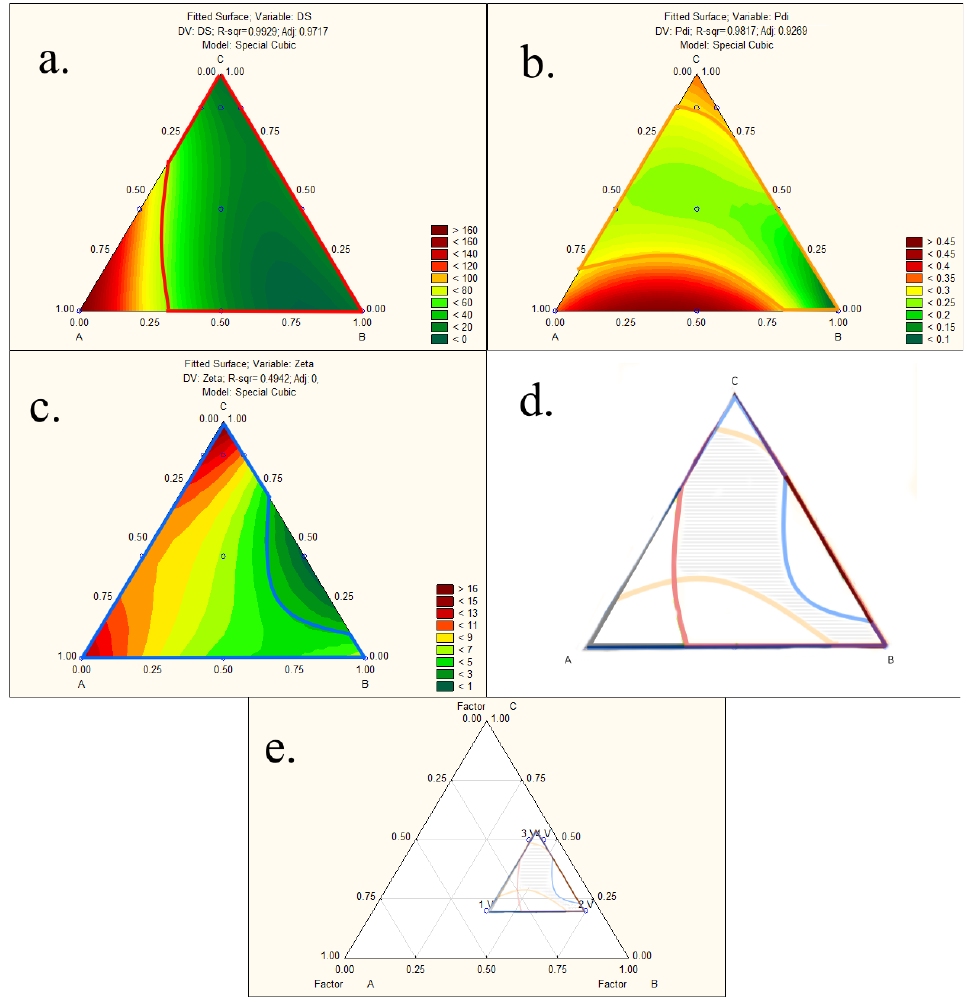
Figure 6. Two-dimensional contour plots of the ( a ) droplet size, ( b ) PDI, and ( c ) zeta potential with acceptance criteria (droplet size—red, PDI—orange, zeta potential—blue) and ( d , e ) illustration of the design space (marked area indicates the process design space).